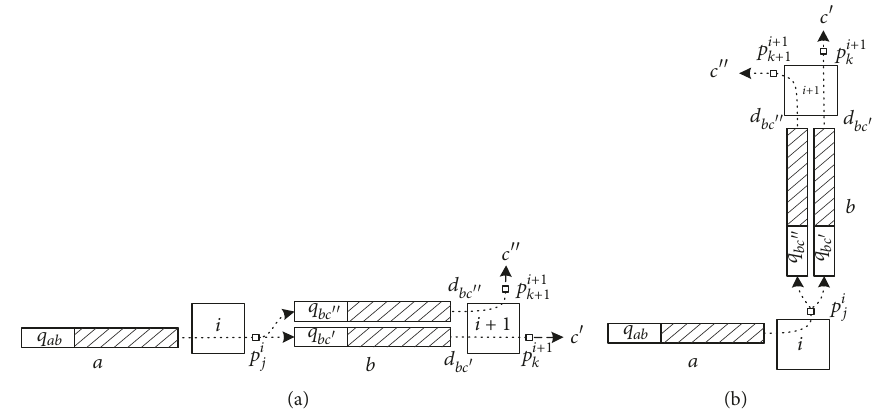
Figure 4: Pressure of straight phase and left-turn phase of intersection i affected by downstream intersection i +1. (a) Straight phase of intersection i affected by downstream light phase; (b) left-turn phase of intersection i affected by downstream light